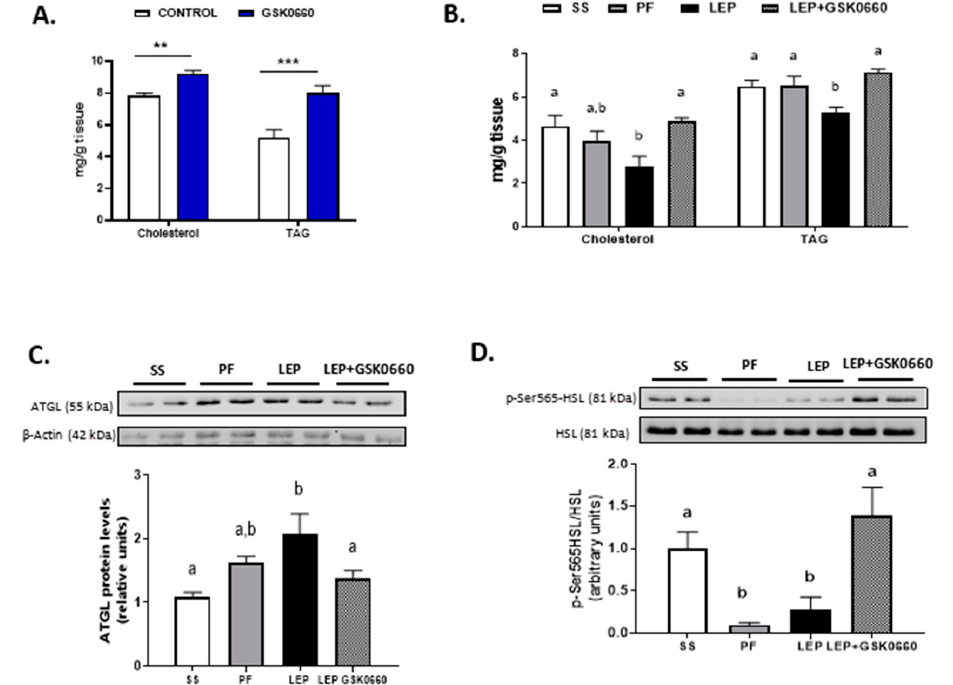
Figure 3. ( A ) Cholesterol and triglyceride (TAG) levels in eWAT in rats after 7 days of vehicle (DMSO) control or antagonist GSK0660 intraperitoneal injection ( n = 6). ( B ) Cholesterol and triglyceride levels in eWAT in rats after 7 days of chronic central treatment of vehicle (SS and PF), leptin, or leptin and ip GSK0660 co-administration ( n = 4–6). ( C ) Representative Western Blot and relative densitometric analysis of ATGL total protein content in eWAT after 7 days of chronic central treatment of vehicle (SS and PF), leptin, or leptin and ip GSK0660 co-administration ( n = 4–6). ( D ) Representative Western blot of p-SER565-HSL and total HSL protein levels and relative densitometric analysis of the ratio p-Ser565HSL/HSL in eWAT of rats after 7 days of chronic central treatment of vehicle, leptin, or leptin and GSK0660 co-administration ( n = 4–6). Results are the mean ± SEM per group of animals ( n = 4–6). Densitometric levels of proteins are expressed relative to the SS group the level of which was set at 1.0 arbitrarily. Differences between CONTROL vs. GSK0660 treatment were analyzed by Student’s t -test (** p < 0.01, *** p < 0.0001). Significant differences between ICV-treated rats were analyzed by One-Way ANOVA followed by Tukey test (differences letters mean significant differences among treatments, p ≤ 0.05). a p ≤ 0.05 vs. PF or Lep; b p ≤ 0.05 vs. SS or PF or Lep+GSK0660. SS: vehicle-infused rats fed ad libitum, PF: vehicle-infused pair-fed rats; Lep: leptin-infused rats; Lep+GSK0660: leptin-infused rats plus PPAR β / δ antagonist GSK0660.